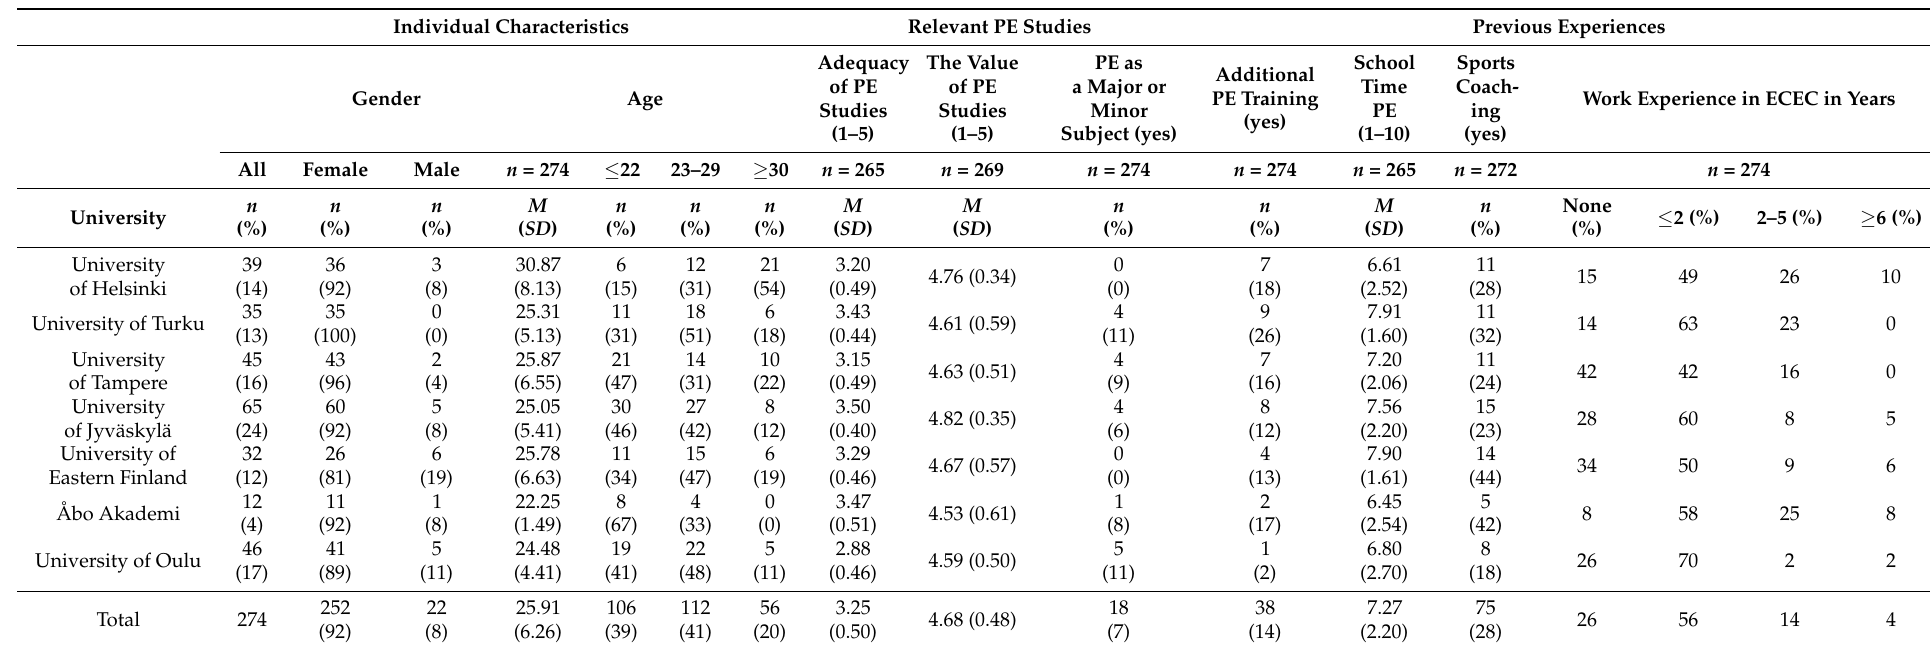
Table 1. Demographic and variable